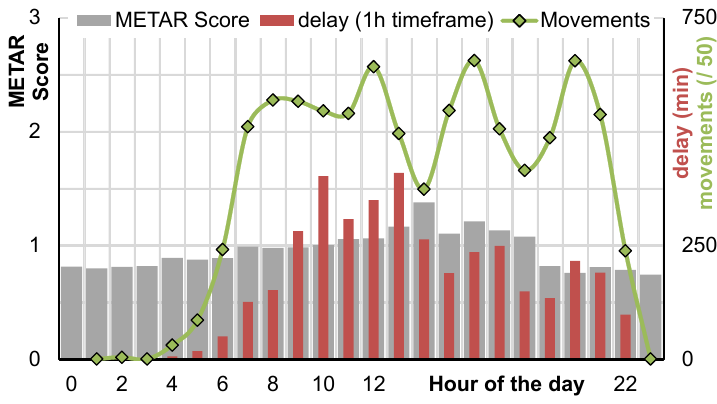
Figure 6. Average weather score and total delay (per